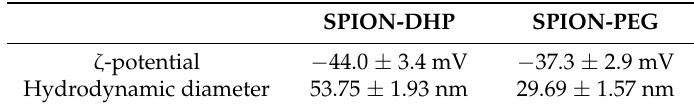
Table 1. ζ -potential and hydrodynamic radius of the functionalized superparamagnetic iron oxide nanoparticles (SPIONs) obtained by dynamic light scattering (DLS) (Figures S2 and S3).